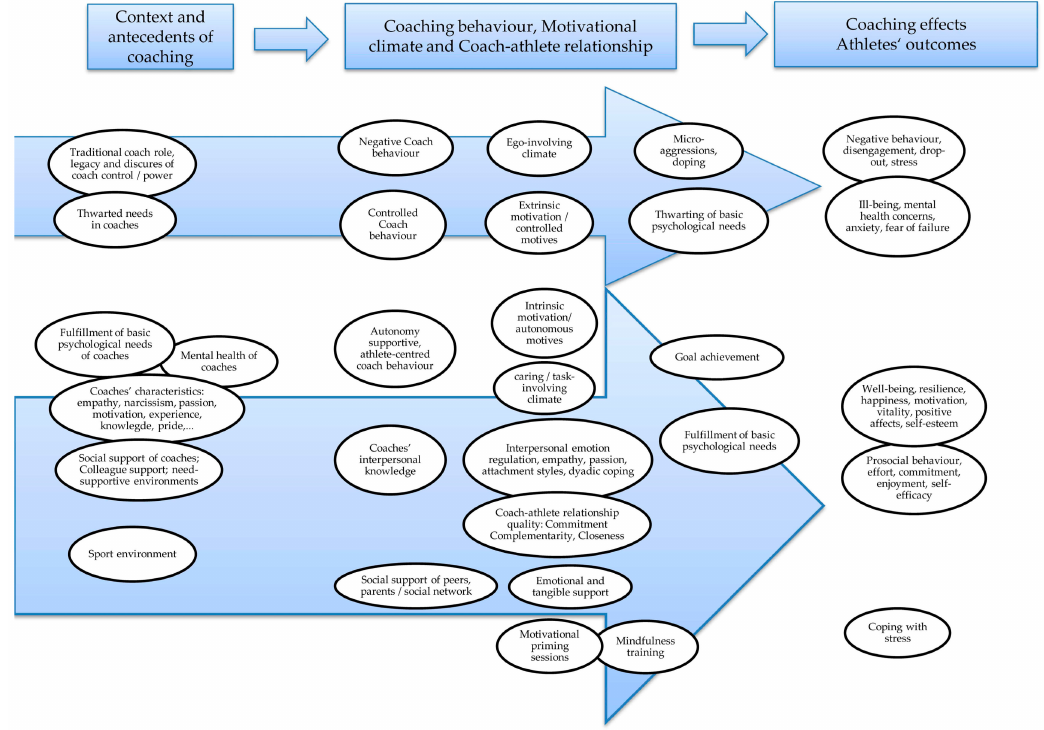
Figure 2. Conceptual map of themes according to coaching context, behavior and outcome on mental